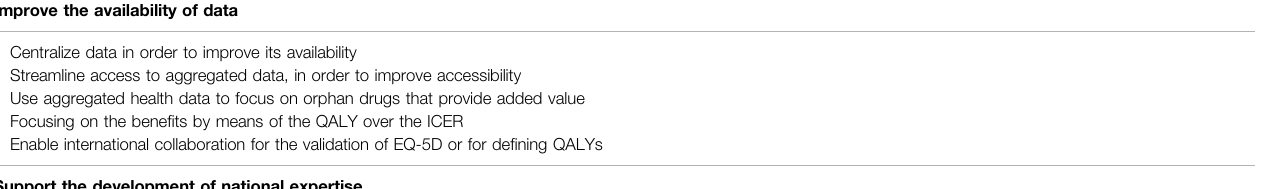
TABLE 4 | Recommendations for optimizing the reimbursement process as shared by experts on orphan drug reimbursement. Improve the availability of data